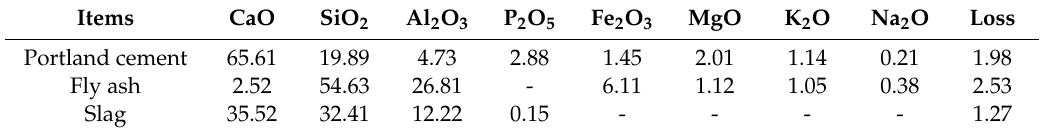
Table 1. Chemical compositions of cementitious materials / %.